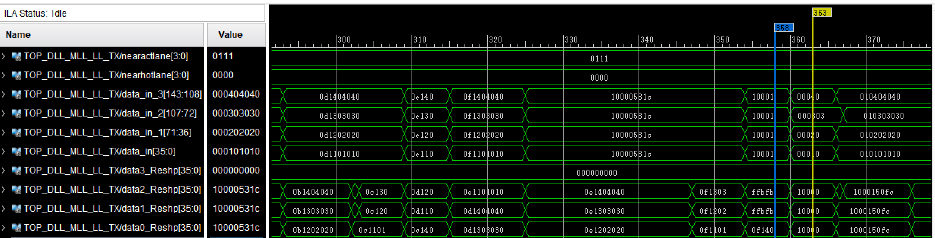
Figure 12. The ILA waveform of the modified word re-ordering block.